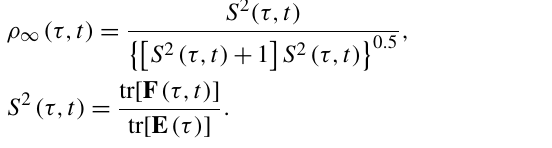
Figure 1. Schematic of LIM forecast for a lead time of